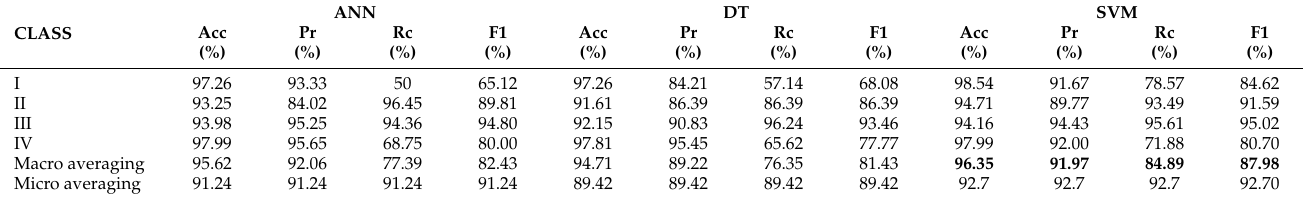
Table 11. Performance of ANN, DT, and SVM models based on the accuracy (Acc), precision (Pr), recall (Rc) values, and F1-Score (F1).